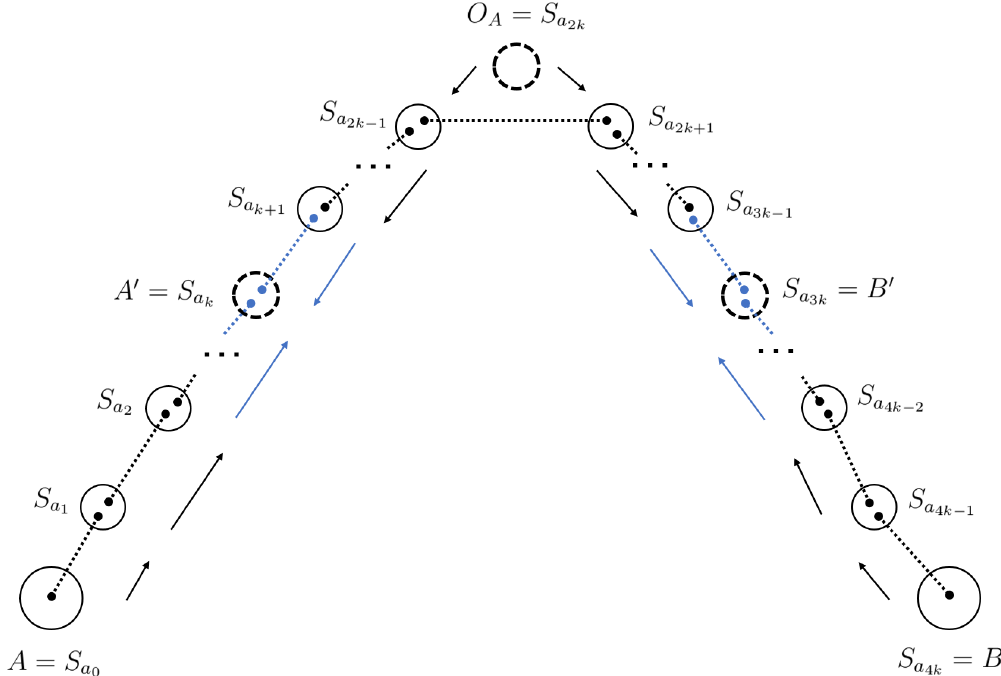
Figure 4. The distribution process of our scheme converges to A (cid:48) and B (cid:48) , where the last Bell measurements are performed, as indicated by blue arrows and blue colored entangled qubits that arrive